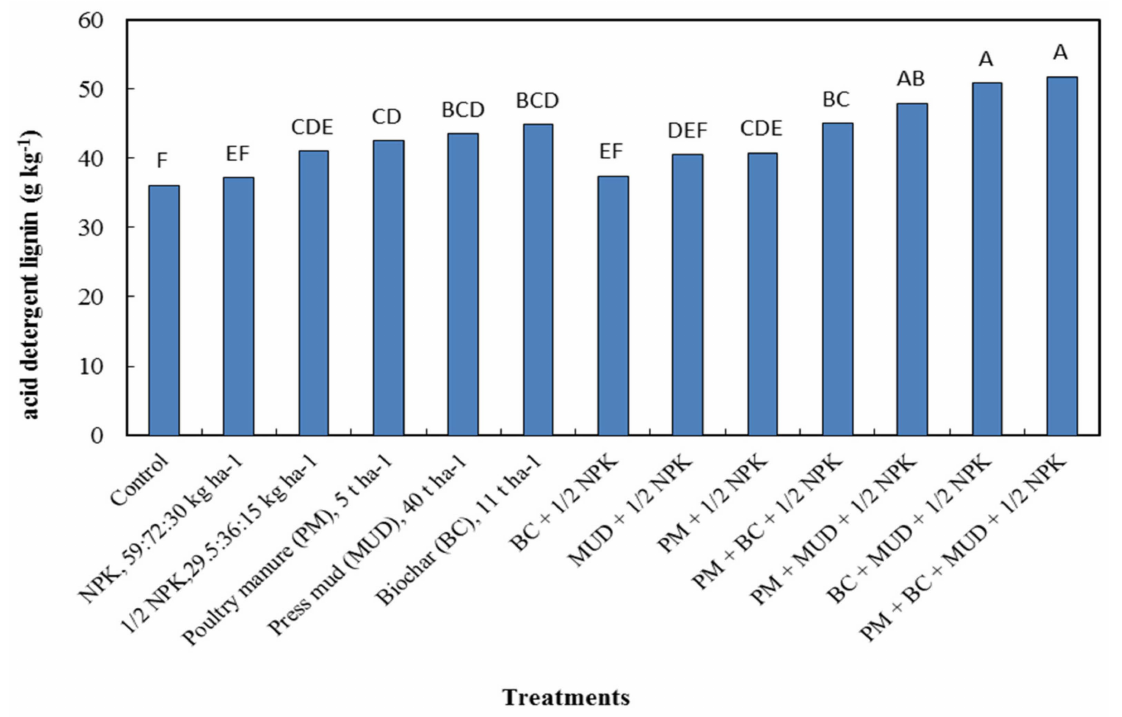
Figure 4. Effect of organic and inorganic amendments on acid detergent lignin of forage sorghum under the field conditions of Layyah, Pakistan. Values are the means of two years and three replicates. Means with similar letters at the top of the bar did not differ significantly at p ≤ 0.05 (HSD =